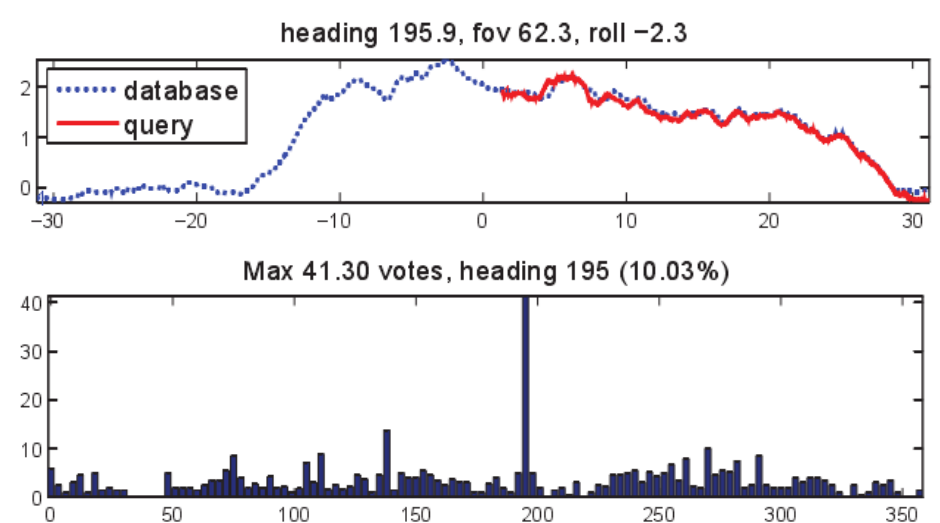
Figure 4. Enumeration method for estimating camera orientation. Using a combination of various pa- rameters within a predetermined range, the skyline with the highest matching score after calibration is found to determine the camera orientation.